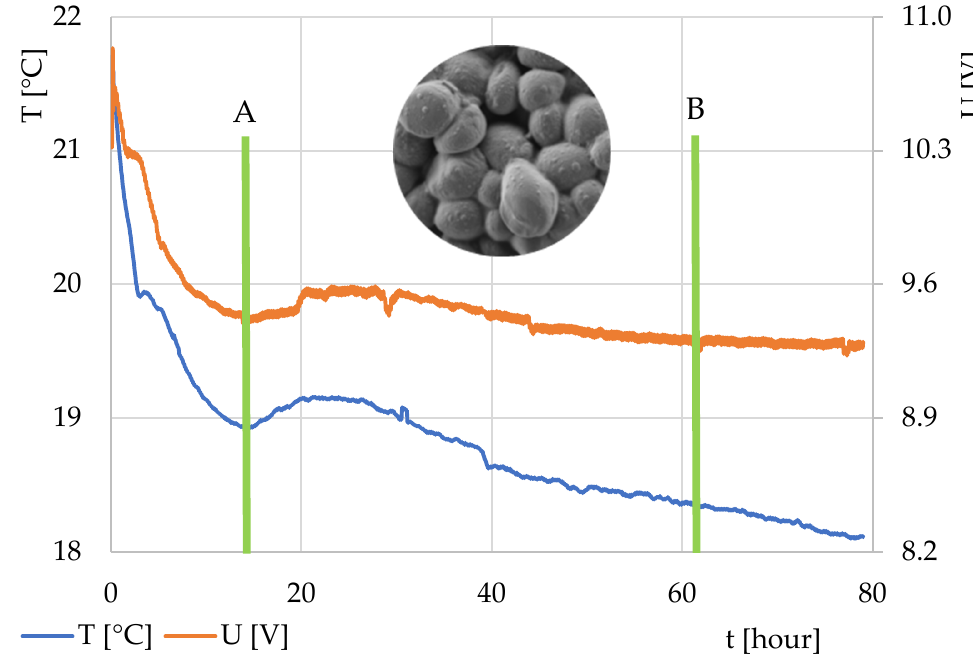
Figure 5. Monitoring process of top fermentation of wort in Experiment No. 1—dried yeast tempered to ambient temperature. Curve description: orange, TDS output voltage; blue, temperature of the plastic fermentation vessel. Lines a and b indicate the beginning and end of the fermentation process. The electron microscope image shows the yeast used in the form of the basic dried material.